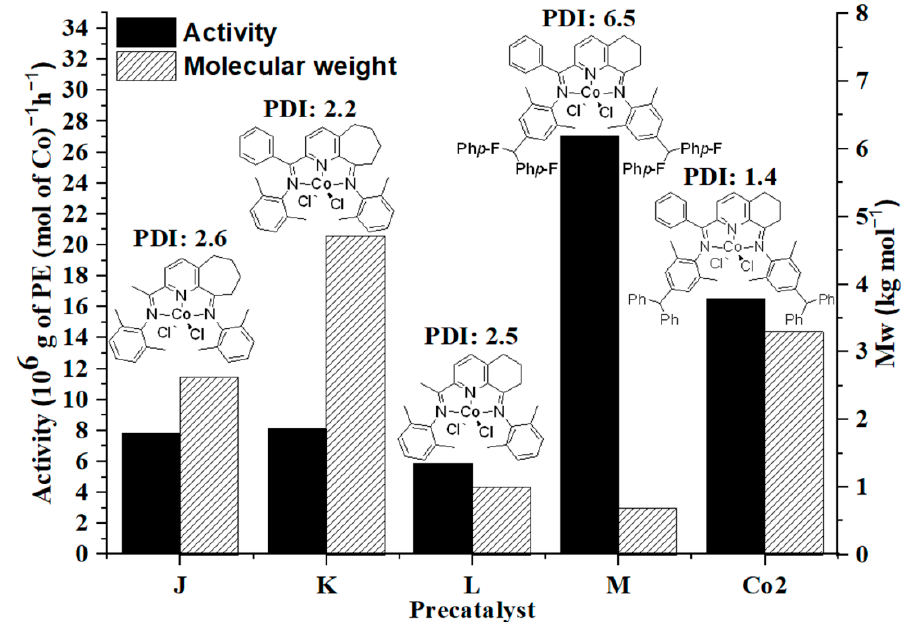
Figure 7. Comparative catalytic performance of I – L with Co2 (entry 2, Table 3) under their respective optimum conditions.